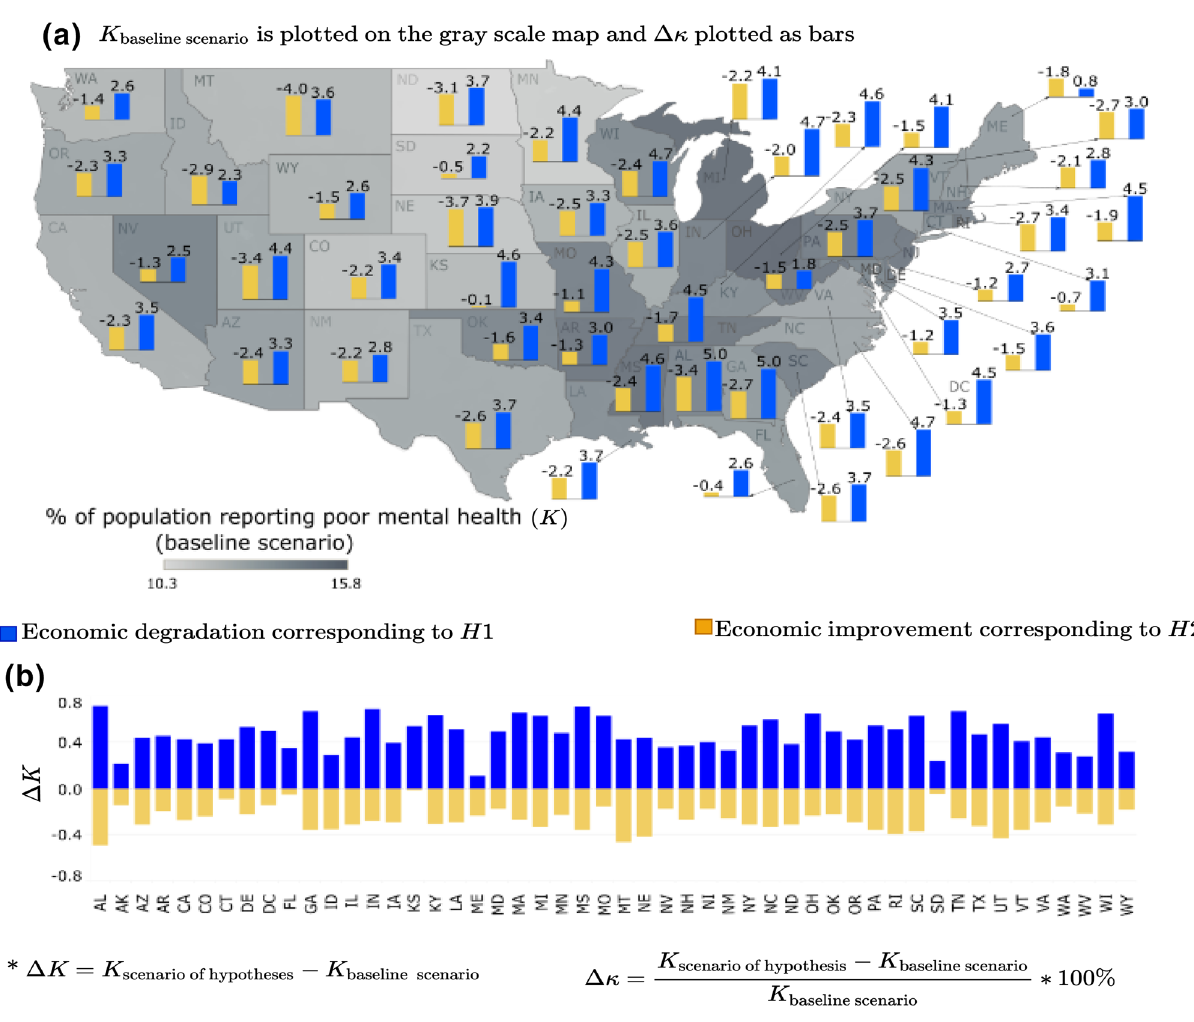
Figure 3. Economic condition scenario for % of adults aged > 18 years reporting poor mental health for > 14 days ( K ): ( a ) �κ is plotted as the bars and K for base line scenario is plotted as gray scale intensity on the US map; and for ( b ) (cid:31) K is plotted. The maps are created using Tableau 2021.2 (Tableau 2021.2 New Features) and Adobe Illustrator (Software and services for creative business teams | Adobe Creative Cloud for